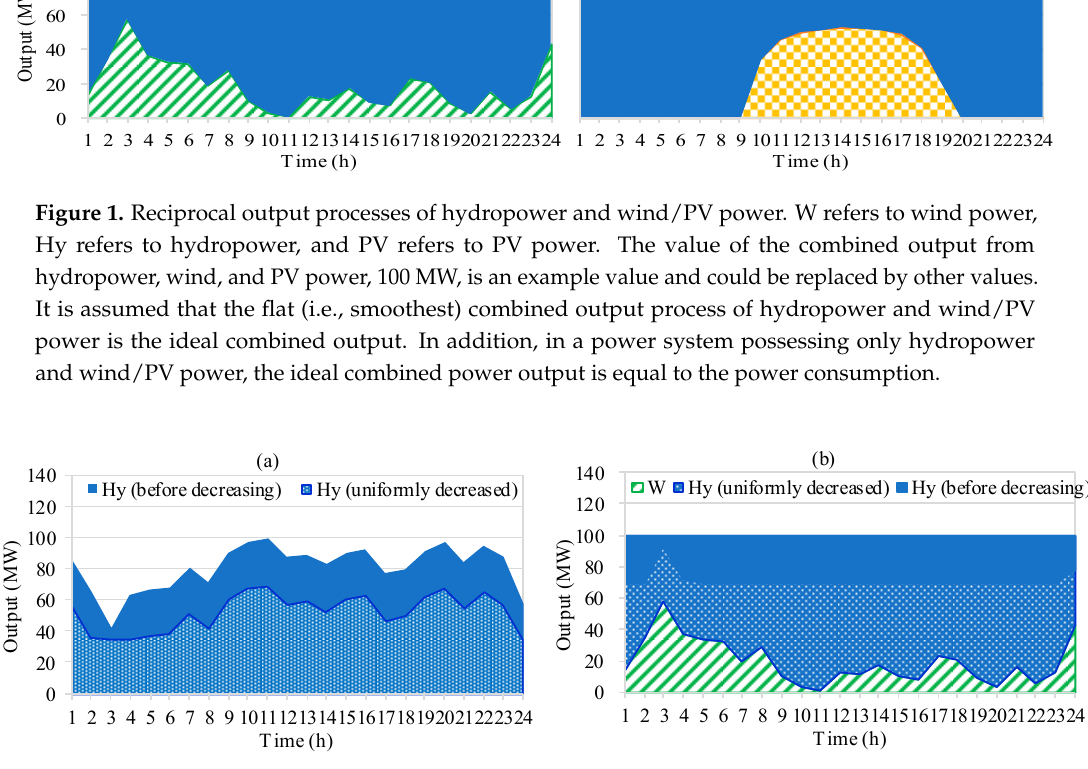
Figure 2. Diagram illustrating the hydropower output process being uniformly decreased by 30 MW (assuming that decreasing the hydropower output by 30 MW would reduce the generation amount gap and the hydropower minimum output is 35 MW). ( a ) Hydropower output processes before the decrease and after being decreased. ( b ) Wind power output were combined with the hydropower output processes in the left panel. This is limited by the minimum output. The hydropower output at 3:00 and 24:00 cannot be reduced lower than 35 MW. (b) W Hy (before increasing) Hy (uniformly increased)